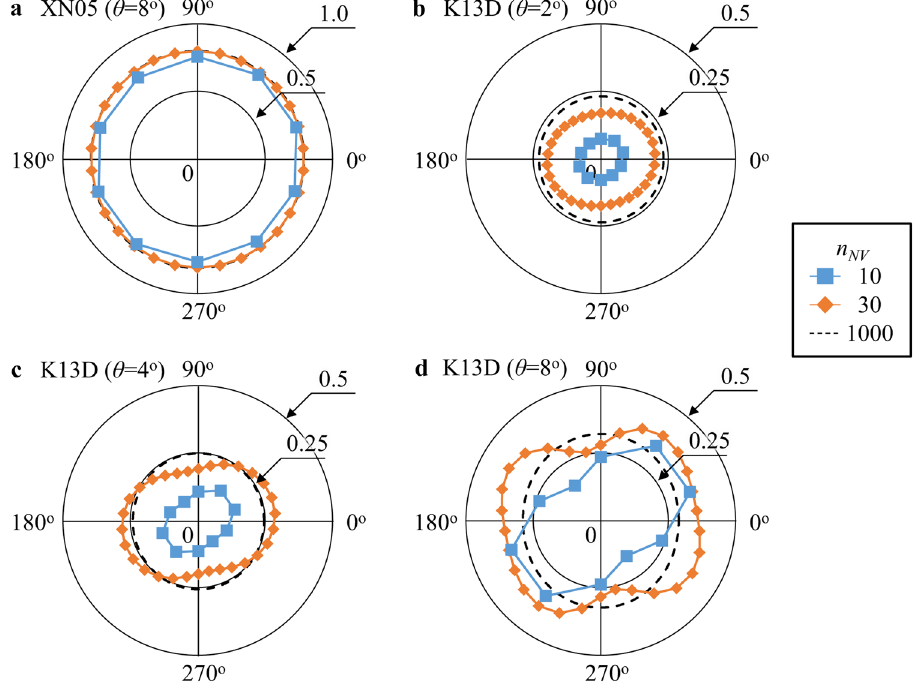
Fig. 5 The anisotropy index ( A ( n ) required to achieve an RMS VN mercially available carbon